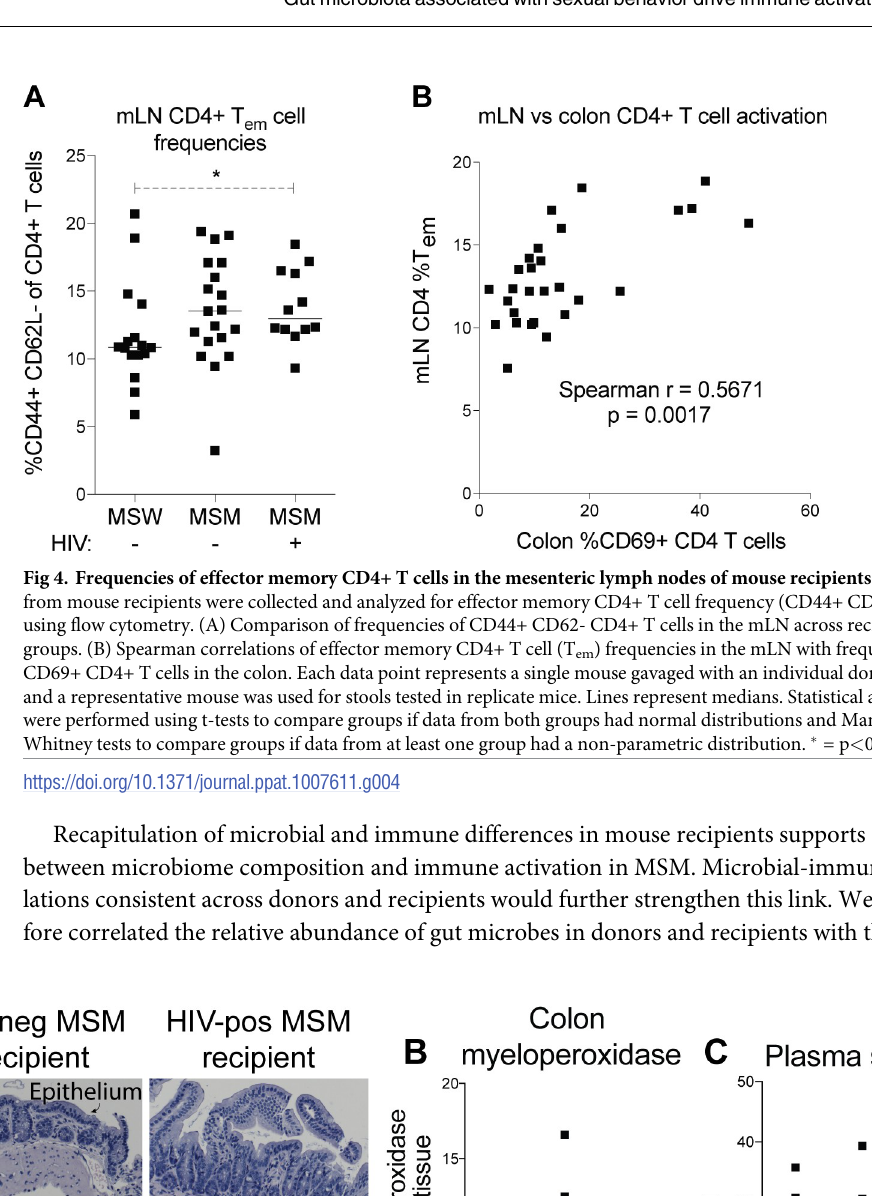
PLOS Pathogens| https://doi.org/10.1371/journal.ppat.1007611 April 4,